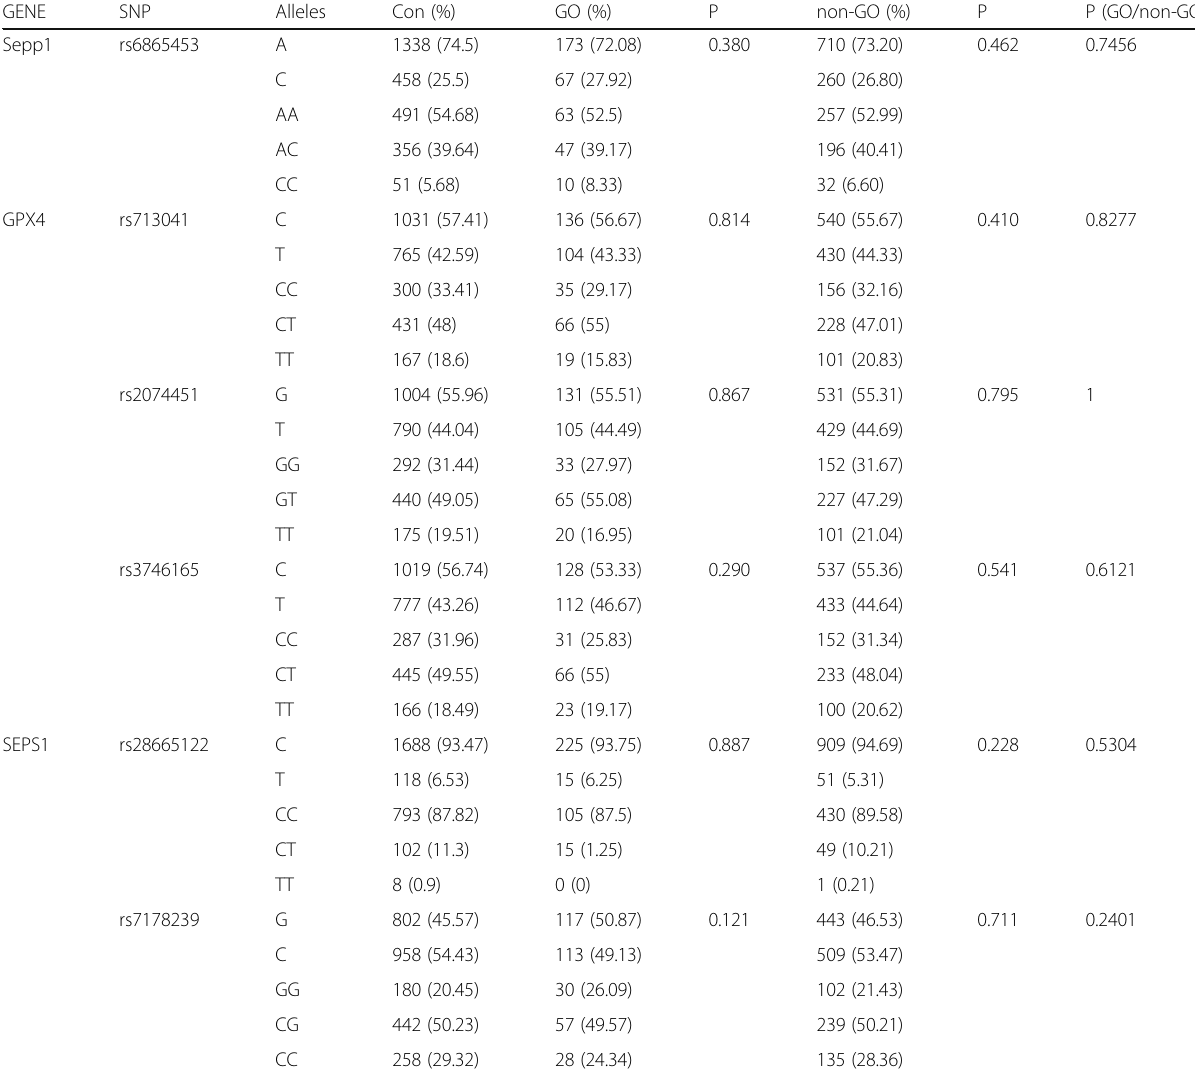
Table 4 Allele and genotype frequencies in GD patients with or without ophthalmopathy and controls GENE SNP